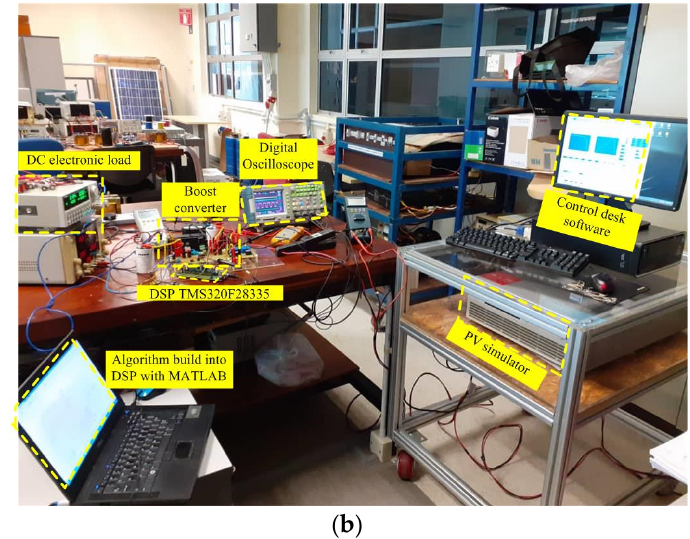
Figure 17. Experimental ( a ) scheme ( b ) setup.